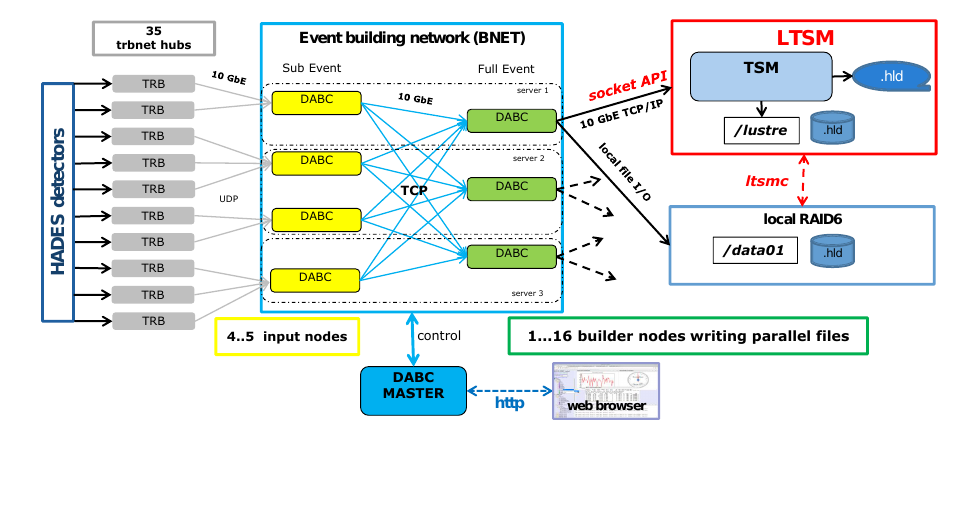
Figure 5. Components of HADES event building in March 2019. See main text for